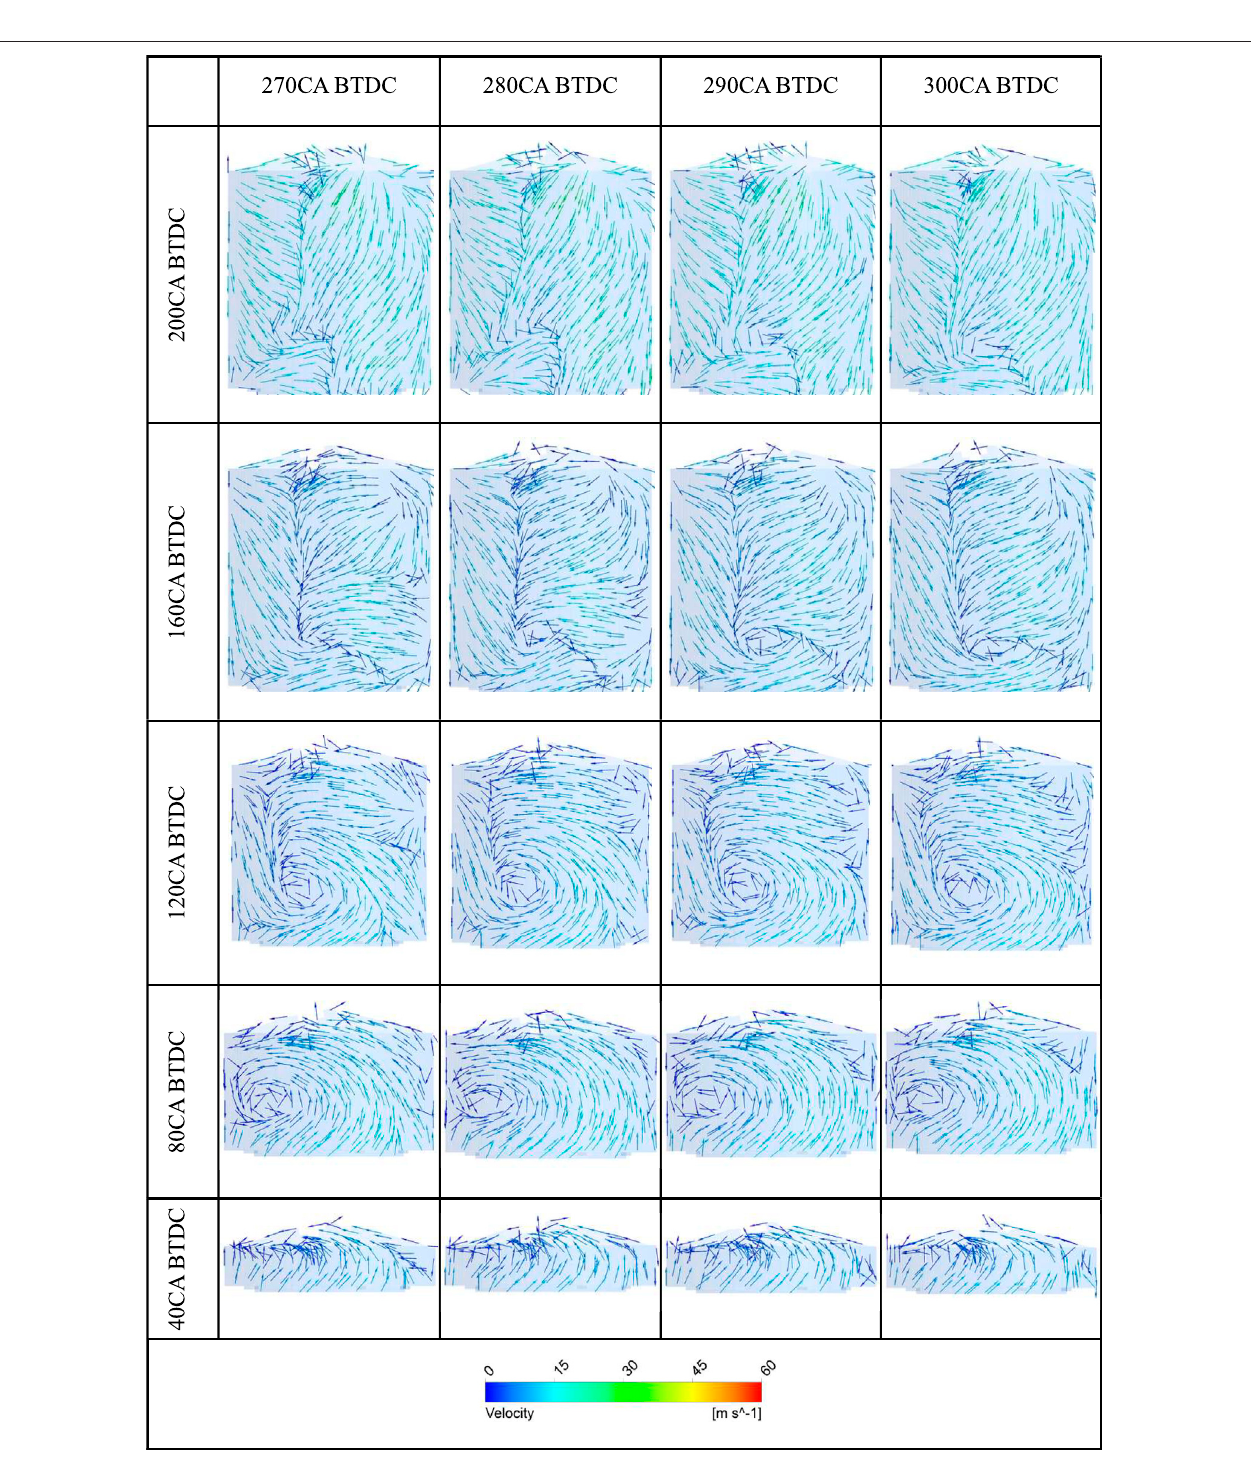
FIGURE 7 | Effect of injection timing on mixture velocity vector diagram at cylinder symmetry at several CAD before spark timing.